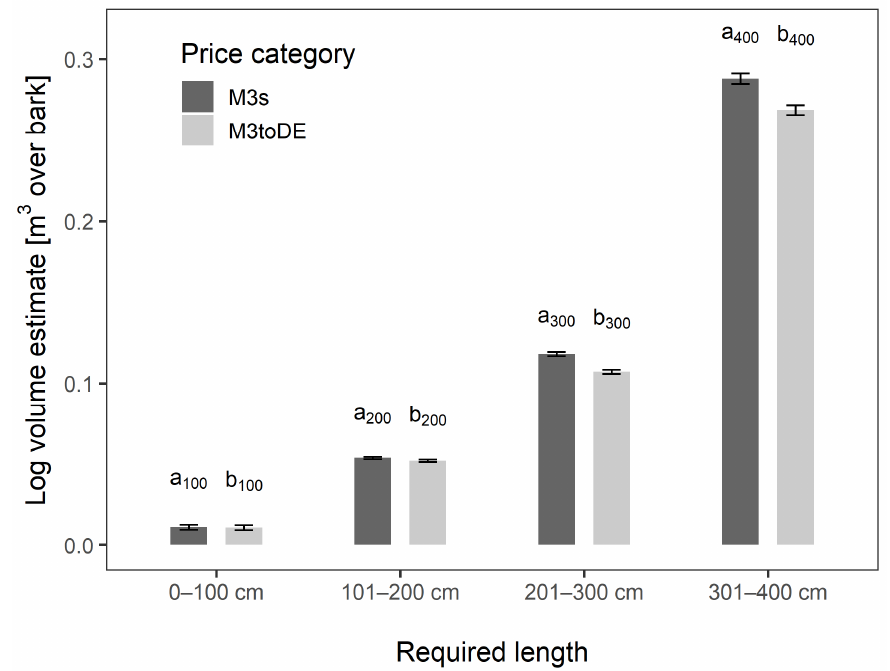
Figure 5. Differences between mean over-bark volumes estimated according to the M3s and M3toDE price categories in individual required length categories of logs. The different letters (a, b) indicate statistically significant differences revealed by the paired Wilcoxon rank-sum test (α = 5%) for each grade separately. Required length categories are distinguished by indices (100, 200, 300, 400), the error bars indicate a 95% confidence interval.